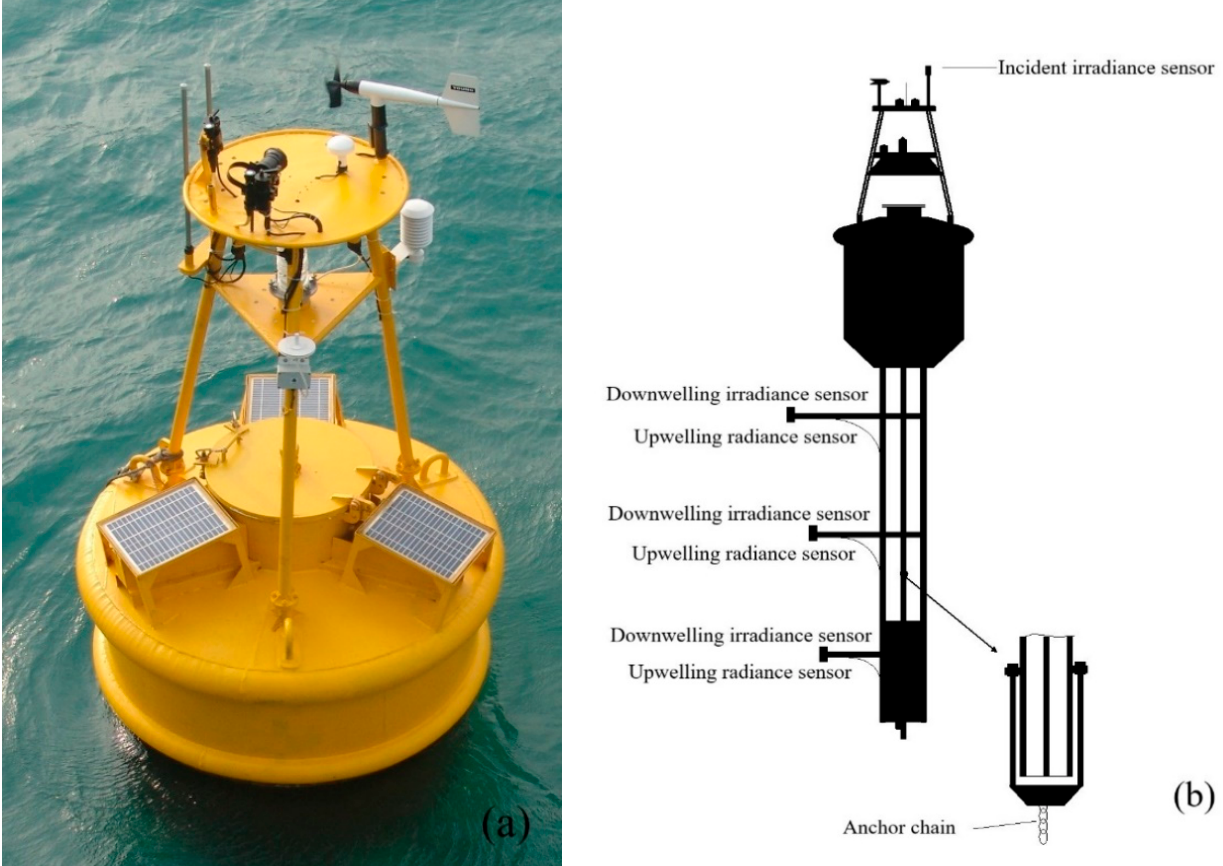
Figure 2. The optical buoy used in this study. ( a ) Photograph of the buoy in operation. ( b ) Schematic of the structure of the buoy.